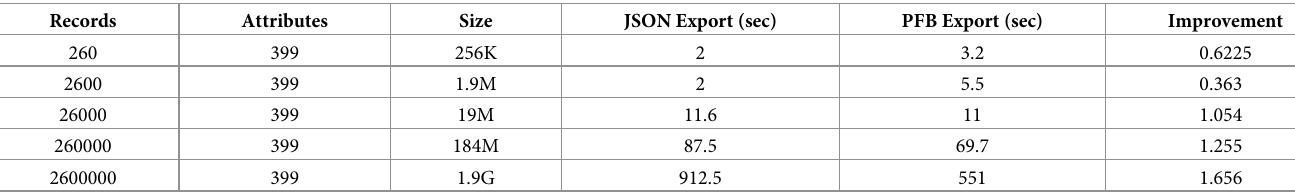
Table 3. Export time comparison between PFB and Gen3.